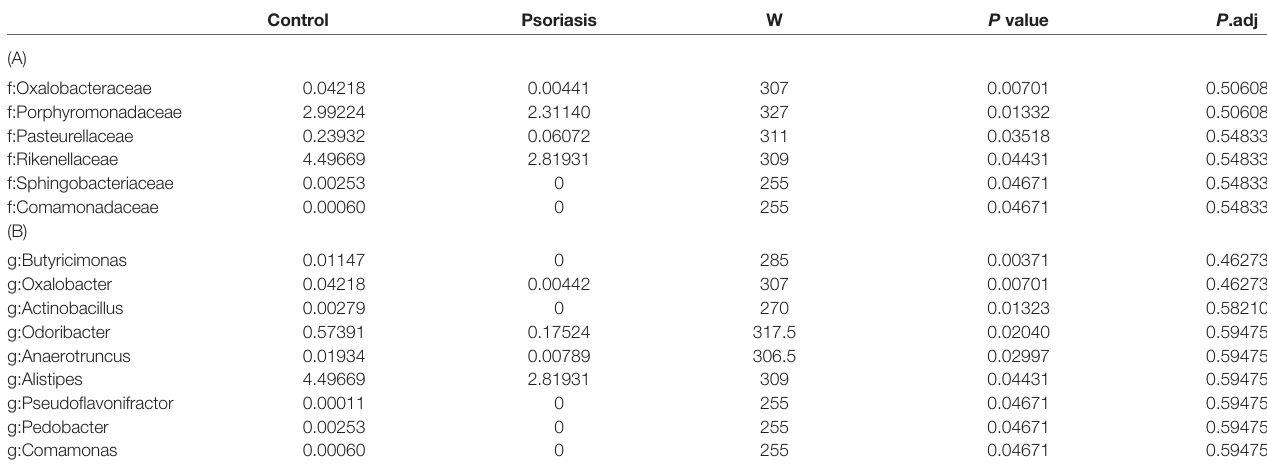
FIGURE 3 | b -Diversity represented as a two-dimensional PCoA showed no differential clustering between the two groups. (The red dots showed the samples from psoriasis patients, whereas the green dots showed the samples from healthy individuals. The closer the dots in one group, the more similar in gut microbiota. The gut microbiota compositions are indicated with red and green circles, respectively. The smaller the overlap of two circles, the more different in the gut microbiota compositions of two groups). TABLE 2 | Taxonomic differences between the psoriasis patients and controls at the family (A) and genus (B) levels. Control Psoriasis W P value P